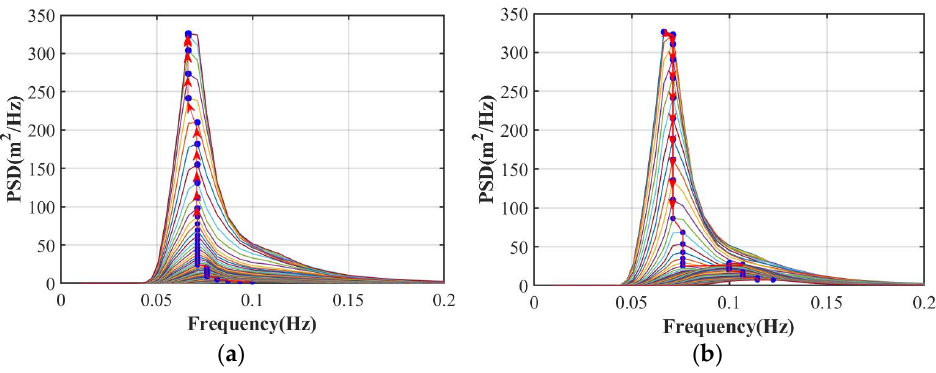
Figure 13. Wave energy spectra at different stages: ( a ) Typhoon arrival process and ( b ) Typhoon departure process.